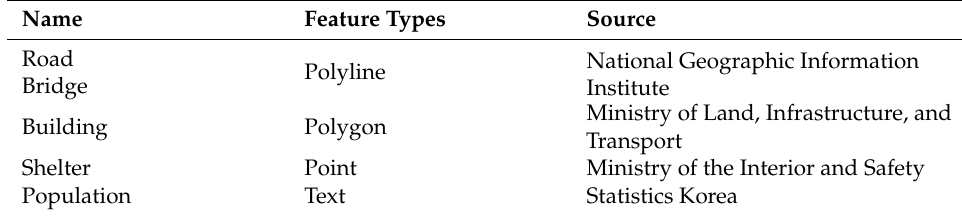
Table 1. Data collection and